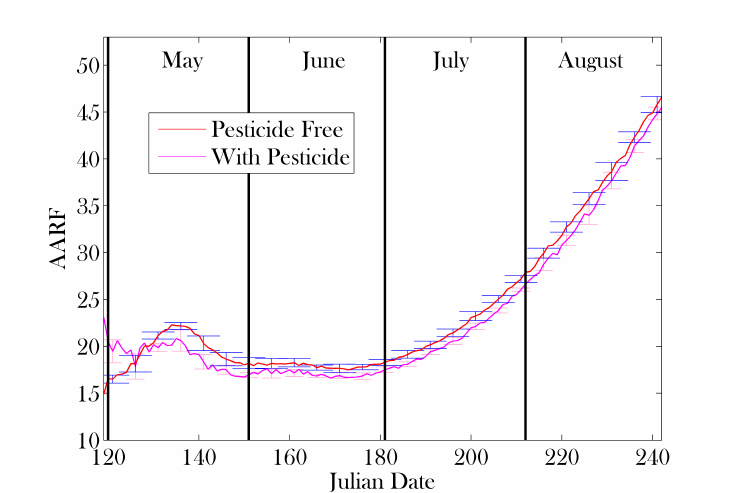
Figure 9. The average age of recruitment to foraging calculated in 7 simulations without pesticides (red line) and a simulation with pesticide treated plants (magenta line) through the summer months. Error bars represent one standard deviation. As mentioned in the text, pesticide exposure in this example affects the navigation abilities of the foragers but does not affect their lifespan, or the age at which they are recruited, thus it may be studied independently from other confounding effects. We see that the AARF is robust against pesticide exposure. We also see that an age of recruitment between 20–30 days corresponds to a healthy colony. An AARF that is above this range could indicate a lack of new brood or problem in the brood, as the increase in the AARF corresponds to the decrease in the brood population in Figure 8. An AARF below this range (as seen in [10,13,74]) can indicate an external stressor (in this case the added stress of early spring on the colony).